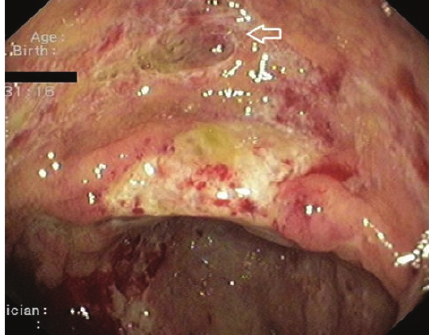
Figure 2: Confluent ulcerations and a “punched-out” ulcer (arrow) in the cecum. Histology revealed atypical cells with possible CMV inclusion bodies.